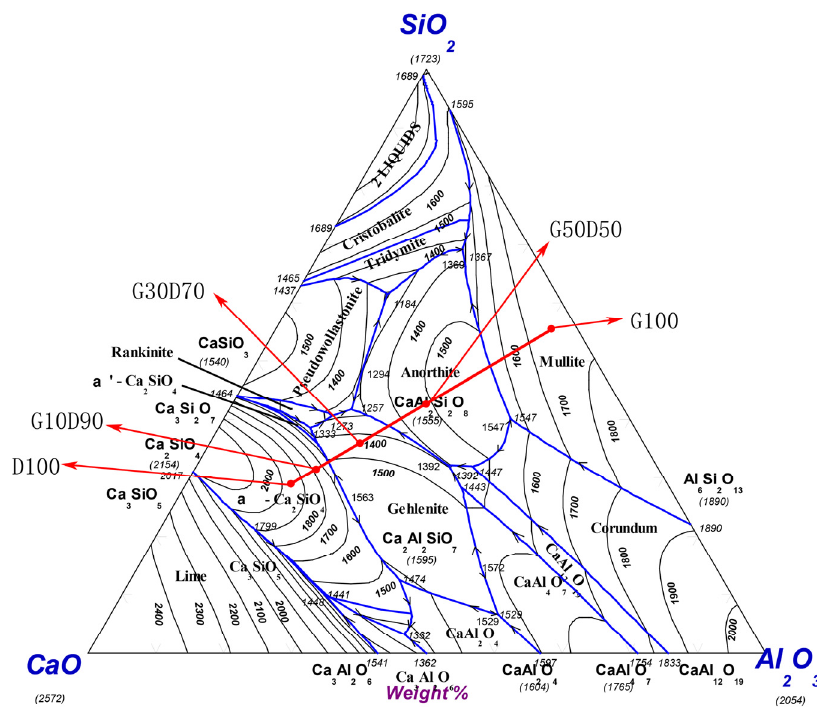
Figure 5. SiO 2 –Al 2 O 3 –CaO ternary phase